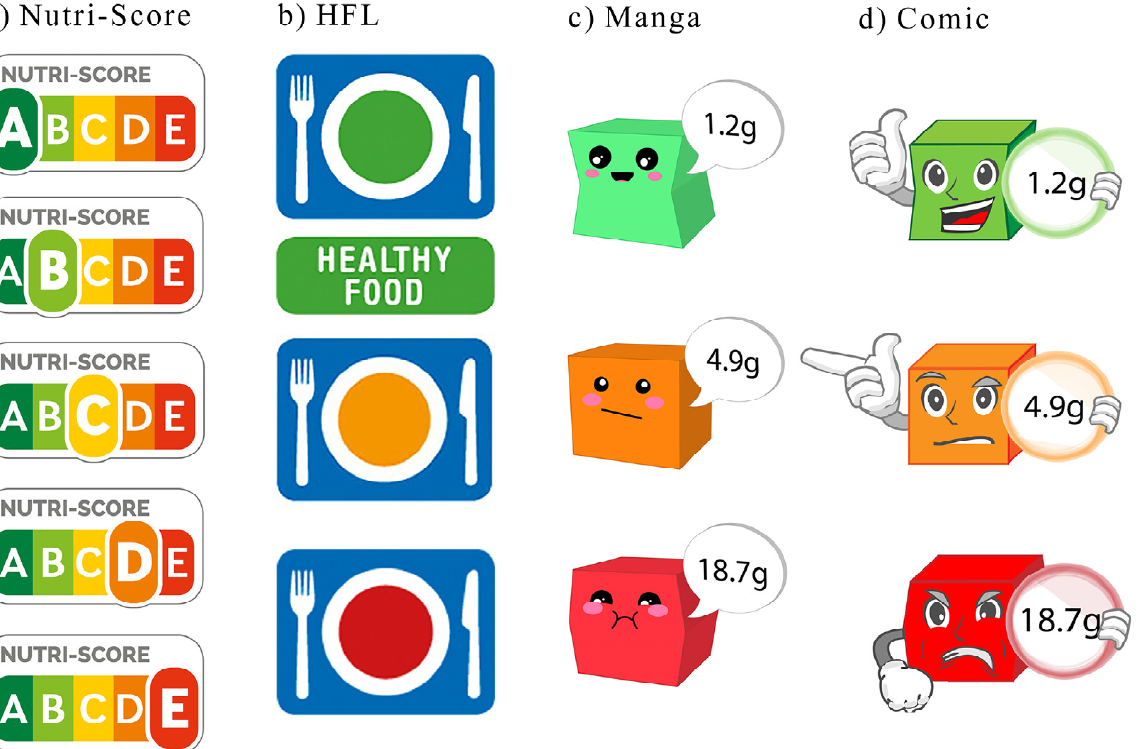
Figure 1. The four different labels used: ( a ) the Nutri-Score, ( b ) the HFL, ( c ) Manga, ( d ) Comic. The last three labels were newly developed. Whereby the HFL is an adoption of the Nutri-Score with just three levels. The Manga and Comic focus on the Sugar content.